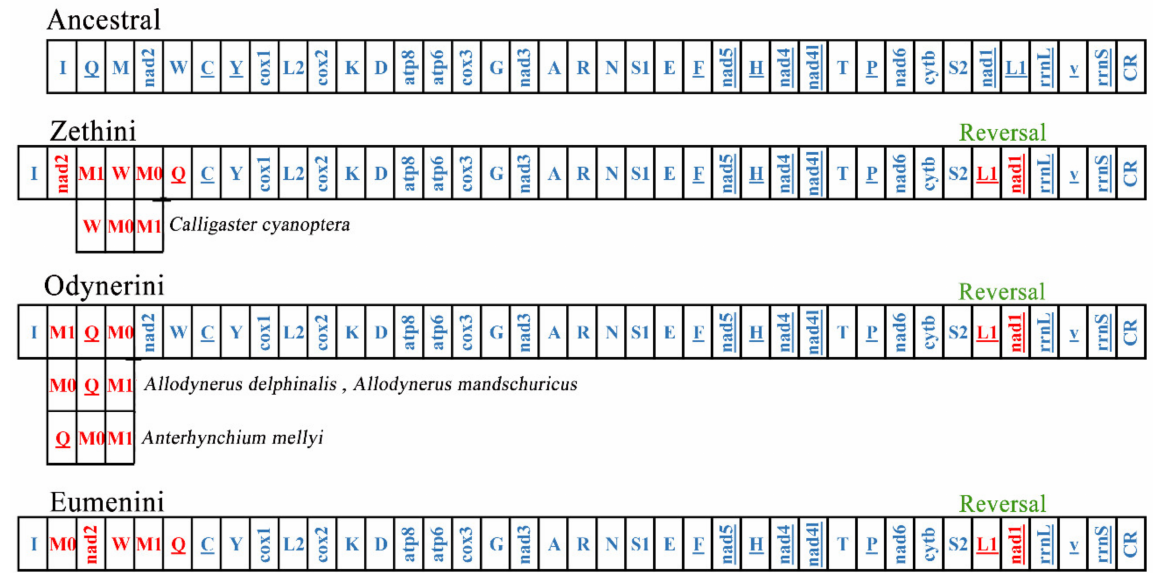
Figure 6. The rearrangement event in three tribes of the subfamily Eumeninae. The red genes represent its’ position changes compared with ancestral